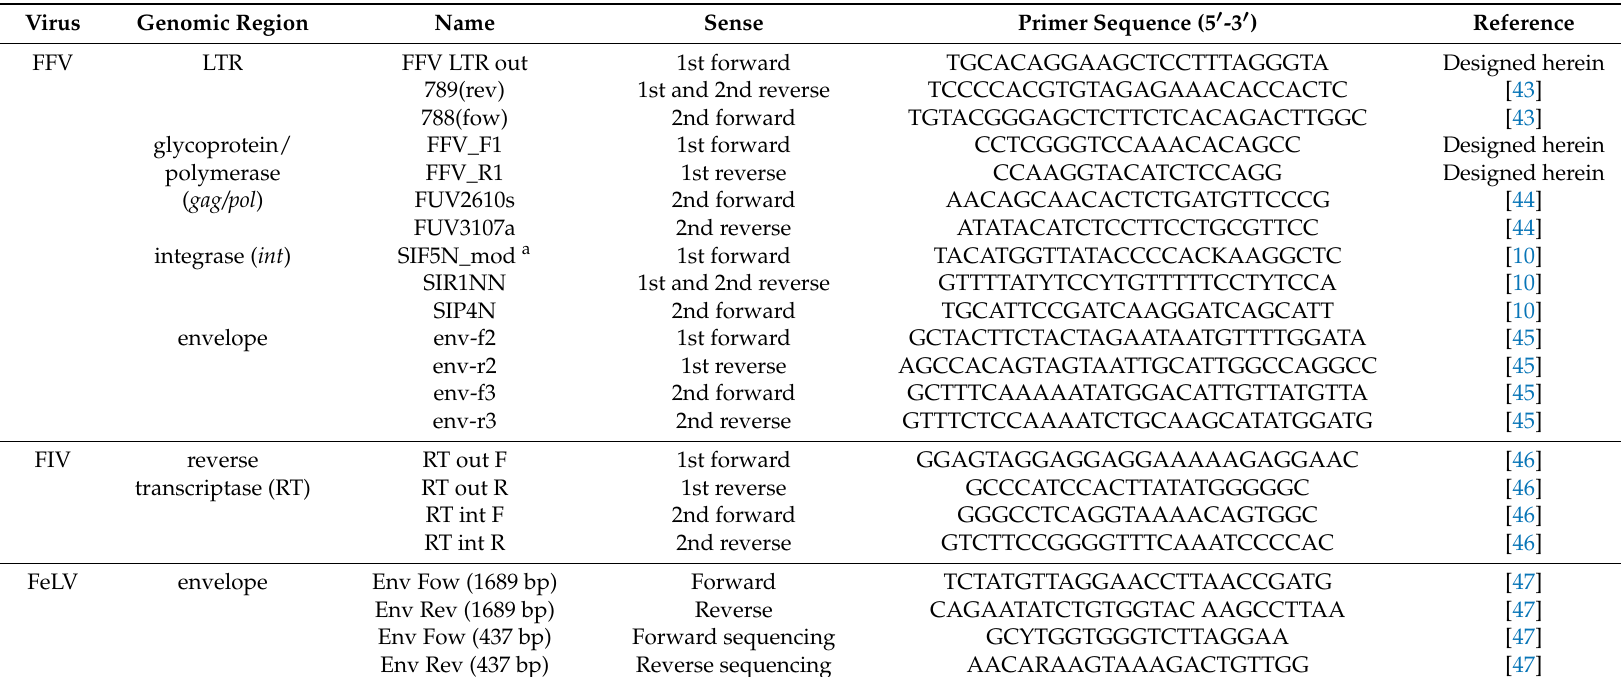
Table 1. Primers used for PCR amplification of feline retrovirus (FFV, FIV and FeLV) genome